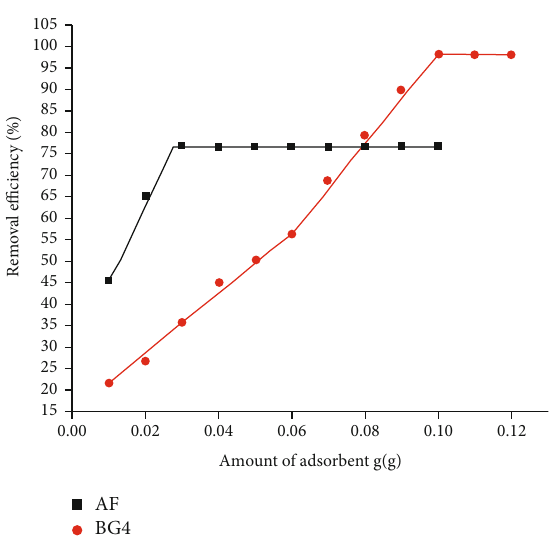
Figure 8: E ff ect of initial dye concentration on dye e ffi ciency removal e ffi ciency of